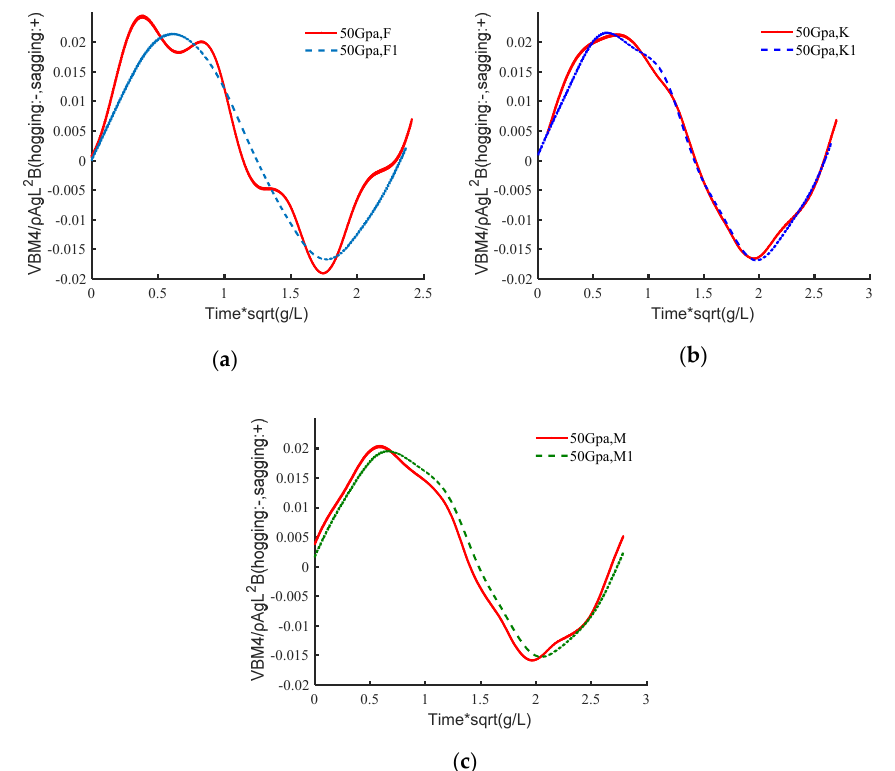
Figure 9. Non-dimensional vertical bending moment response of hull structure with E = 50 Gpa. ( a ) λ /L = 0.857; ( b ) λ /L = 1.070; ( c ) λ /L = 1.228.